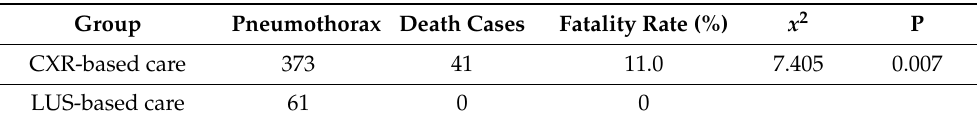
Table 4. The influence of LUS-based care on fatality rate of pneumothorax. Group Pneumothorax Death Cases Fatality Rate (%) x 2